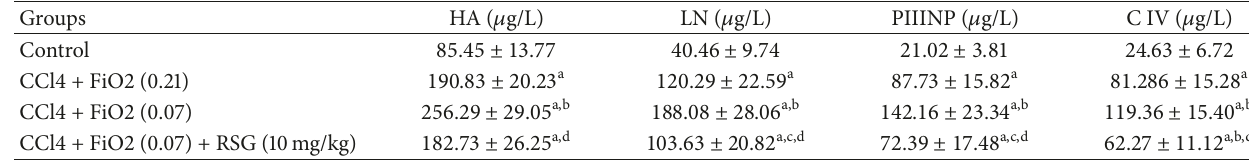
Table 2: Serum levels of HA, LN, PIIINP, and C IV (mean ±